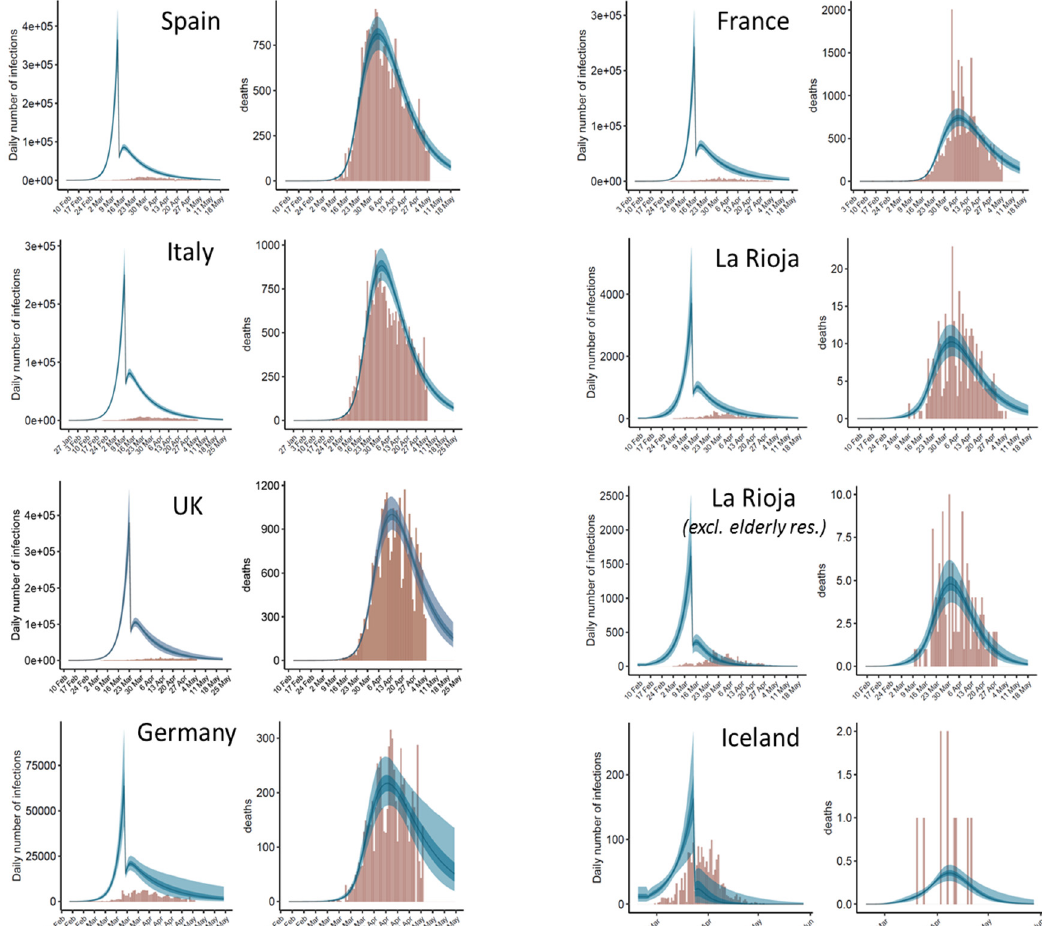
Figure 3. Estimates of infections and deaths over time after independent application of the model to each country and region. For each country, the left plot shows the predicted daily infections as compared with the reported ones, and the right plot shows the expected daily deaths as compared with the observed ones. Expected values are shown as blue bands: light blue (95% CI), dark blue (50% CI) and line (median). Observed values are shown as brown bars. The estimates of R t before and after intervention resulting from the model are the ones in Table 3. In all cases, after intervention, R t is significantly reduced to a value well below 1 and the number of new infections decreases. In the La Rioja second panel, daily observed deaths do not include those from elderly retirement homes, but daily reported cases are the total ones, since the daily reported cases outside elderly residences was not available for this work. Table 3. Estimated reproduction numbers (before and after intervention) and initial number of infections resulting from the model (shown mean values, with 95% credible interval).